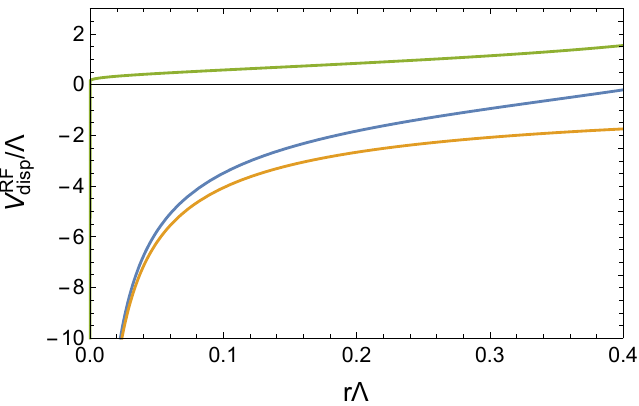
. Orange line shows the (cid:12)rst line of eq. (2.61) MS